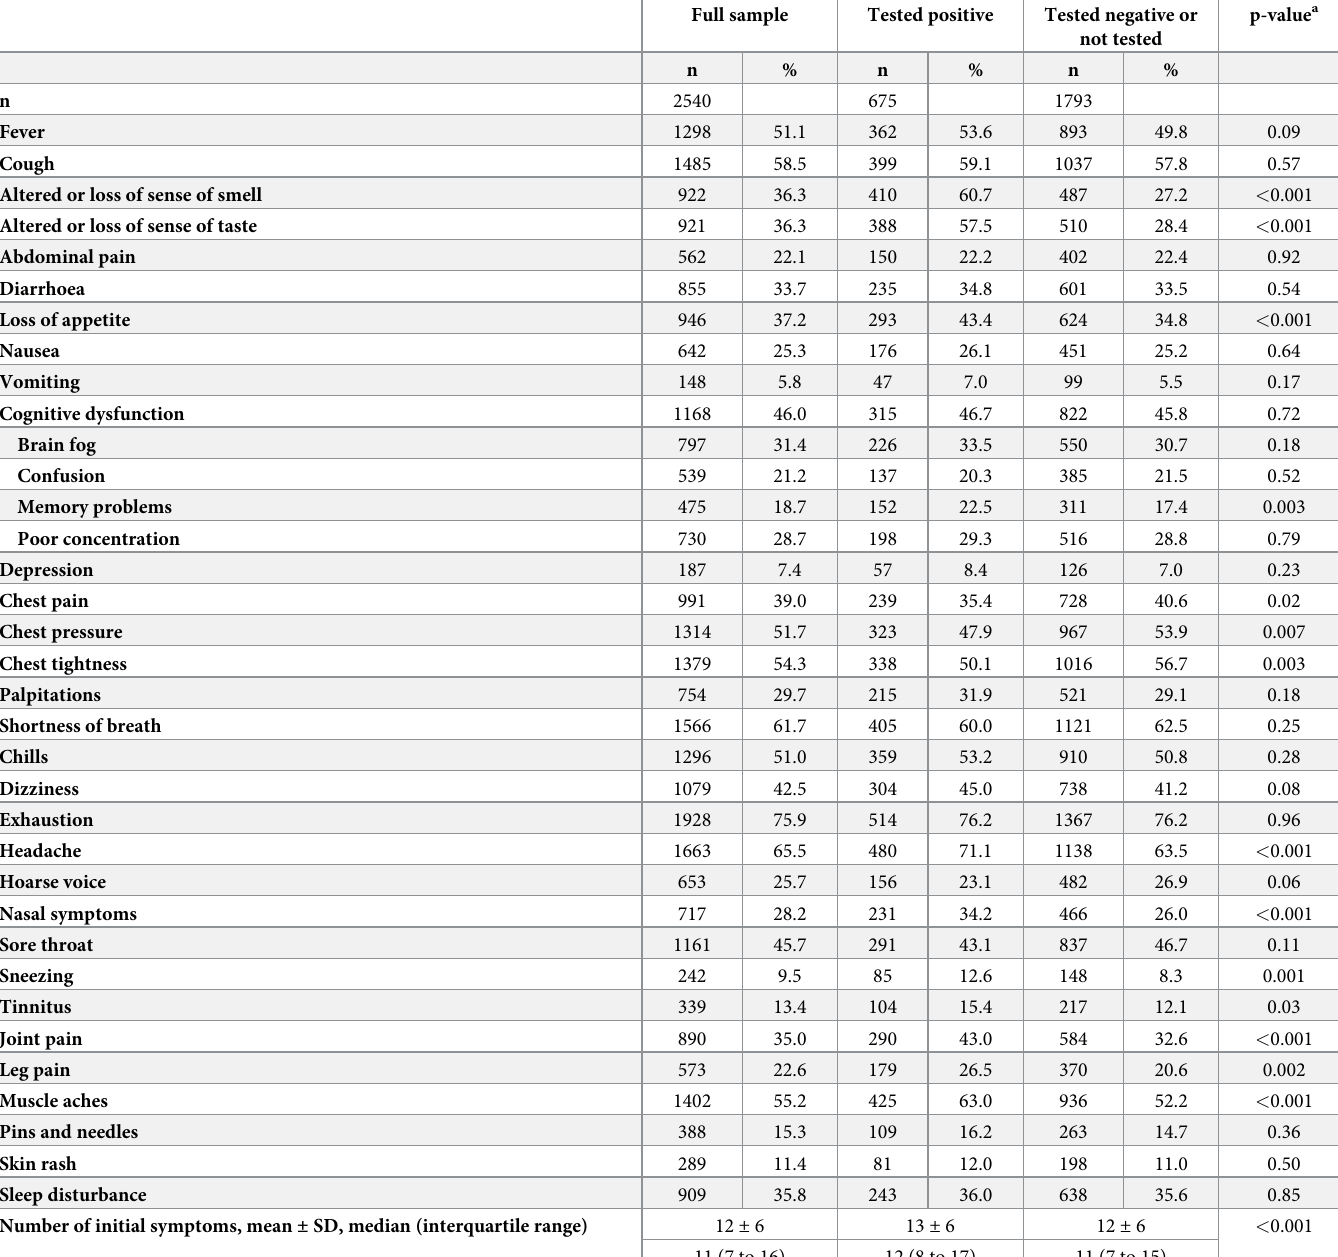
Table 2. Initial symptoms experienced at the start of COVID-19 illness (first two